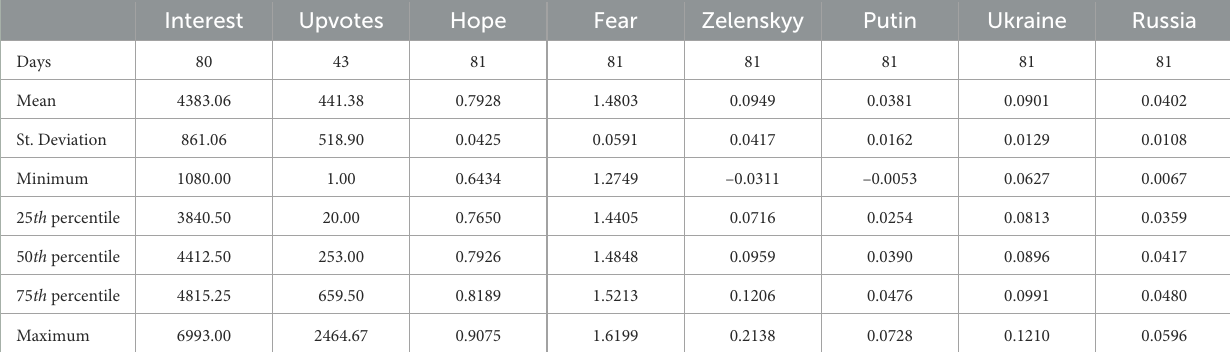
TABLE 1 Descriptive statistics for the whole